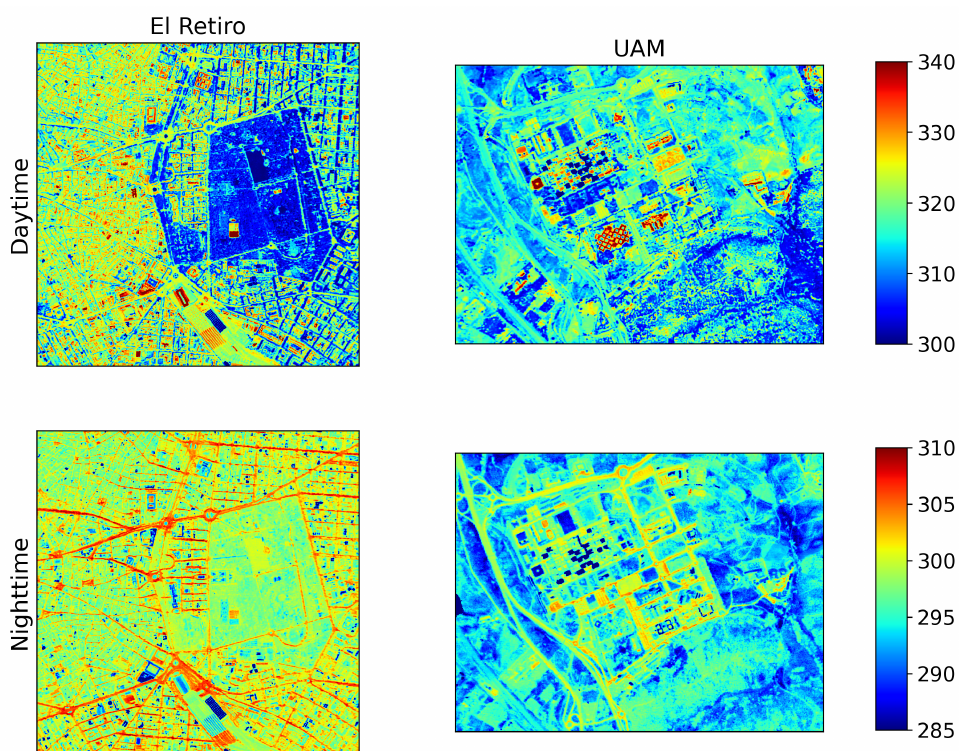
Figure 10. LST in K retrieved from the hlm1MMD-4-band TES over the Retiro Park ( left ) and the UAM ( right ) during the daytime ( top ) and nighttime ( bottom ).